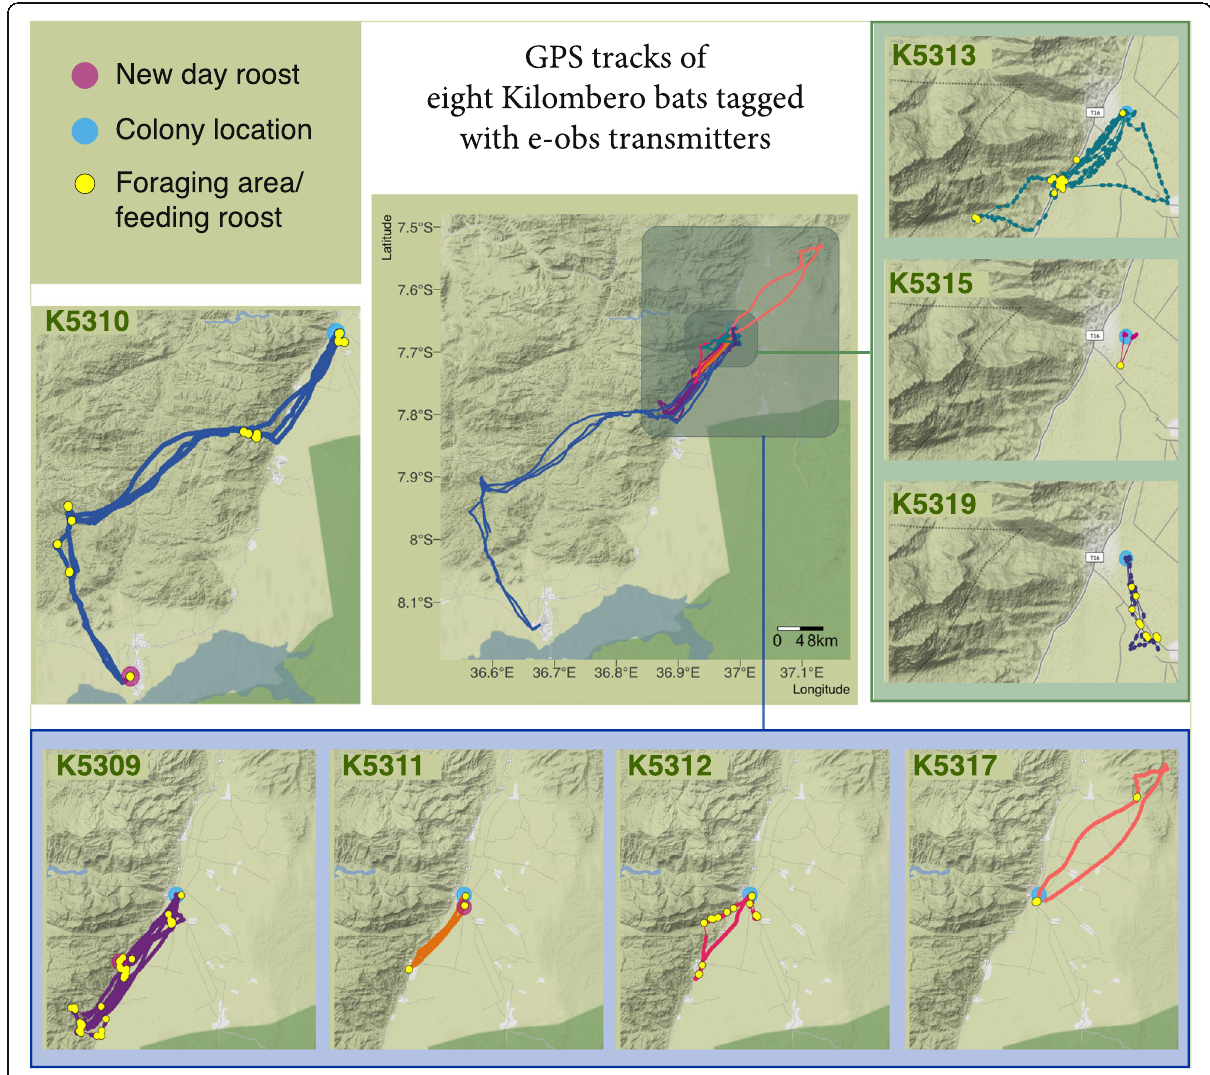
Fig. 2 Map of the tracking data obtained from eight out of ten e-obs tags attached on Eidolon helvum bats in the Kilombero District